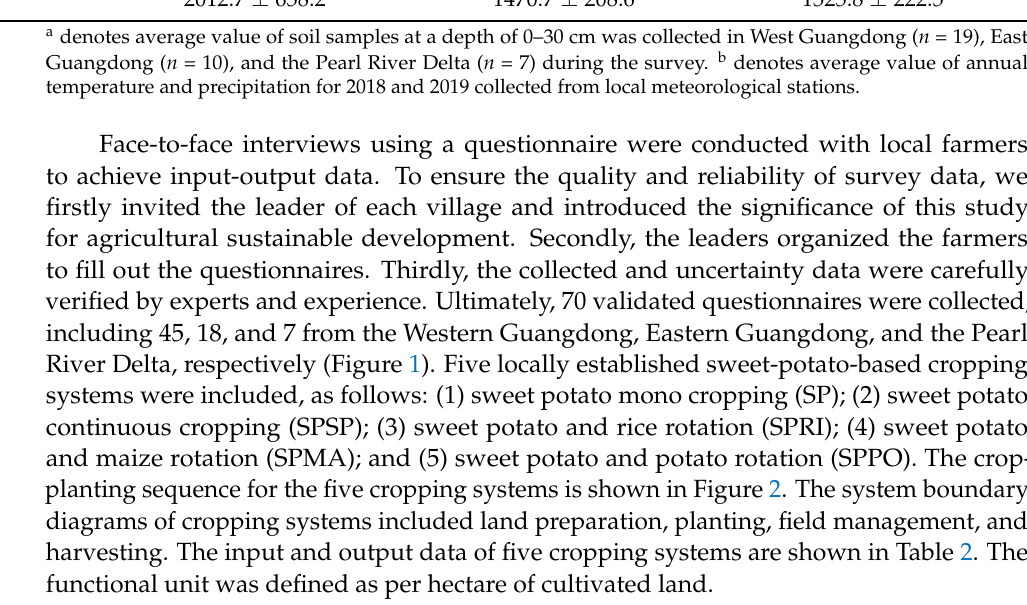
Figure 2. Cultivation time of the five cropping systems within a year. Table 2. Input and output data of five sweet-potato-based cropping systems in Guangdong prov- ince per hectare. Parameter